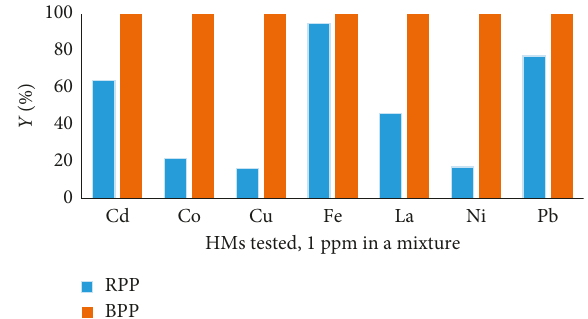
Figure 1: A Comparison of BPP and RPP in the adsorption of HMs from aqueous multielement samples.